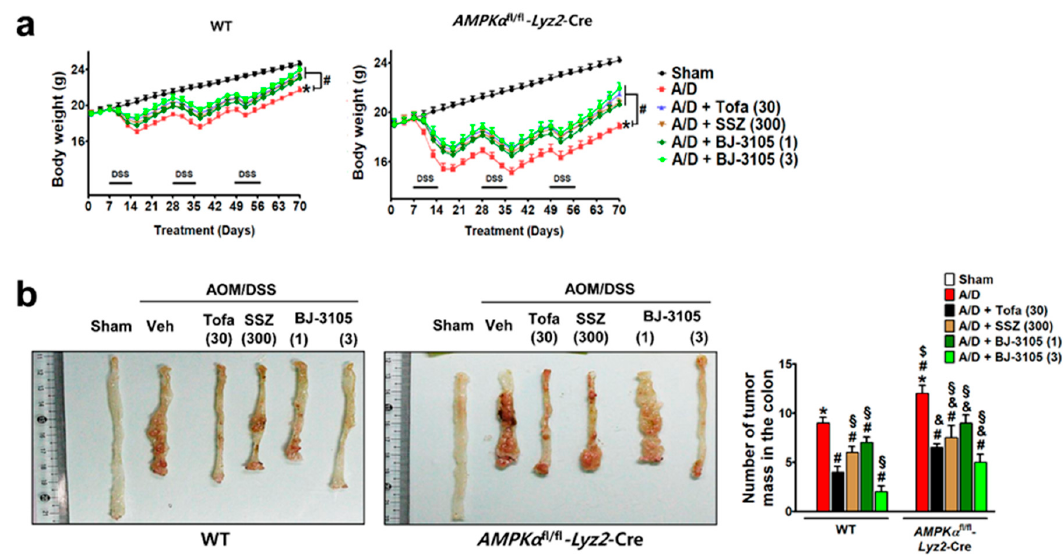
Figure 7. Efficacies of BJ-3105, tofacitinib, and sulfasalazine on tumor formation in AOM/DSS-treated mice. WT and AMPK α fl/fl -Lyz2 -Cre mice were used for the AOM/DSS-induced colitis-associated cancer model experiment. WT and AMPK α fl/fl -Lyz2 -Cre mice were used for the AOM/DSS-induced colitis-associated cancer model experiment. BJ-3105 (1 and 3 mg/kg), tofacitinib (30 mg/kg), or sulfasalazine (SSZ) (300 mg/kg) were administered orally. ( a ) Changes in body weight. ( b ) The representative view of the distal colon lumen. In the macroscopic examination, tumors larger than 2 mm in diameter were counted, and the numbers of tumors are presented as means ± standard errors ( n = 5). * p < 0.05, versus sham-operated WT mice. # p < 0.05, versus AOM/DSS-treated WT mice. $ p < 0.05, versus sham-operated AMPK α fl/fl -Lyz2 -Cre mice. & p < 0.05, versus AOM/DSS-treated mice. § p < 0.05, versus tofacitinib-treated WT or AMPK α fl/fl -Lyz2 -Cre mice.